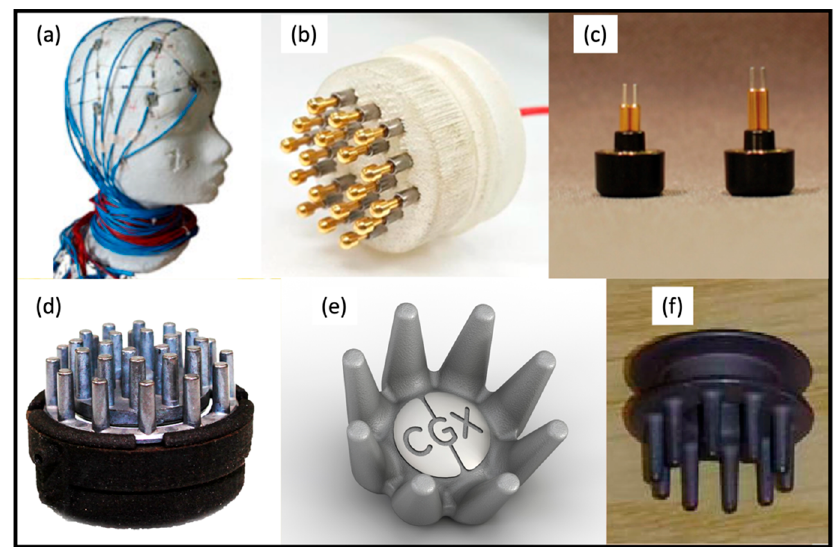
Figure 3. ( a ) The wet AgCl ring electrodes used in the system developed by von Luhmann et al. This figure was taken with permission from [40]. ( b ) The custom-designed prototype of spring-loaded dry electrodes developed by Lee at al. Each electrode contains 18 spring-loaded probes. This figure was taken with permission from [43]. ( c ) A commercial dry electrode used in a single-modal EEG, described by Kam et al. This figure was taken with permission from [59]. ( d – f ) Examples of commercial dry fingered EEG electrodes: ( d ) wearable sensing [64], ( e ) CGX [65], ( f ) neuroelectrics [66]. These figures were taken with permission from [64], [65], and [66], respectively.